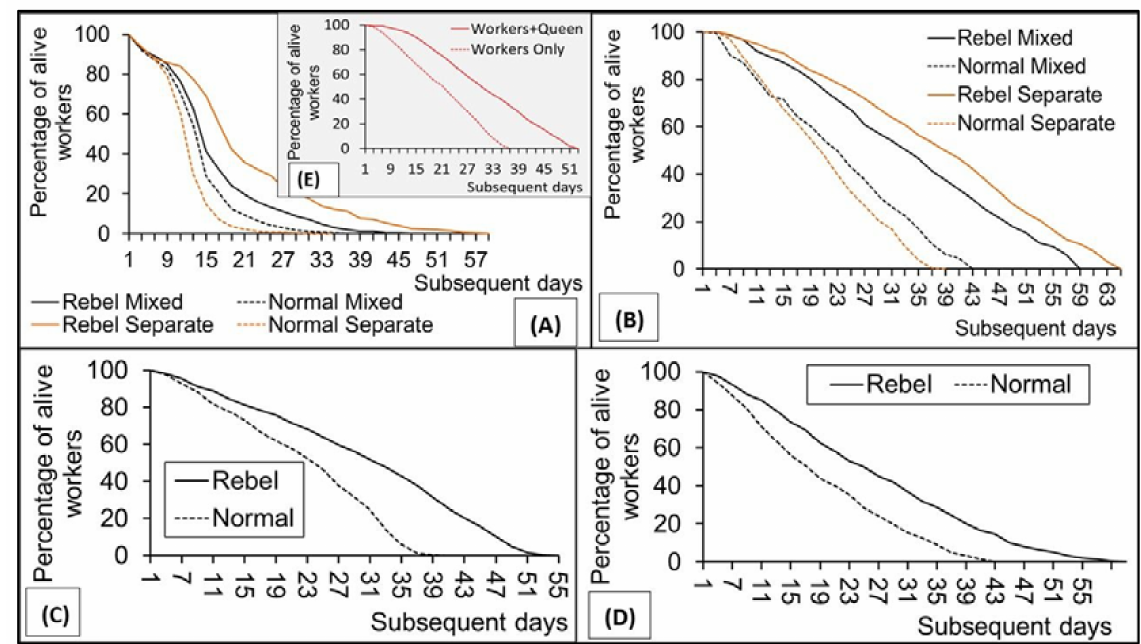
Figure 2. Survival of the rebel and normal workers kept in cages ( A , B —repetition 1 and 2) and survival of the rebel and normal workers kept in hives ( C , D —repetition 1 and 2). Survival of the normal workers kept in the cages with queens or without queens ( E ). Explanations: Rebel Mixed and Normal Mixed—cages contained both rebel and normal workers (RW + NW). Rebel Separate and Normal Separate—the rebel or normal workers were kept in the separate